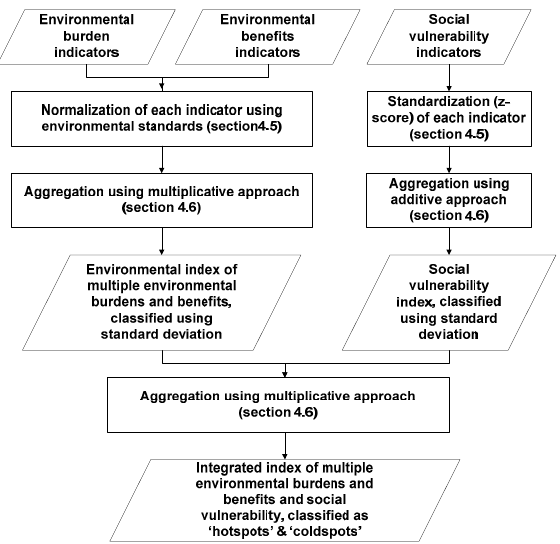
Figure 1. Methodological procedure to develop integrated index of multiple environmental burdens and benefits with social vulnerability of population.